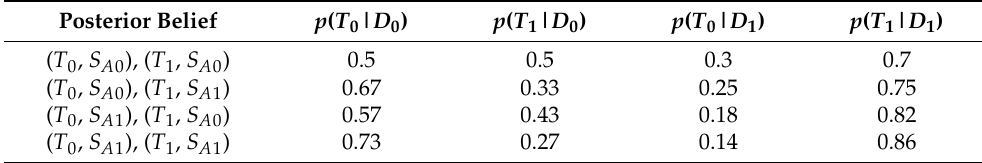
Table 6. Posterior Belief of the Defender.